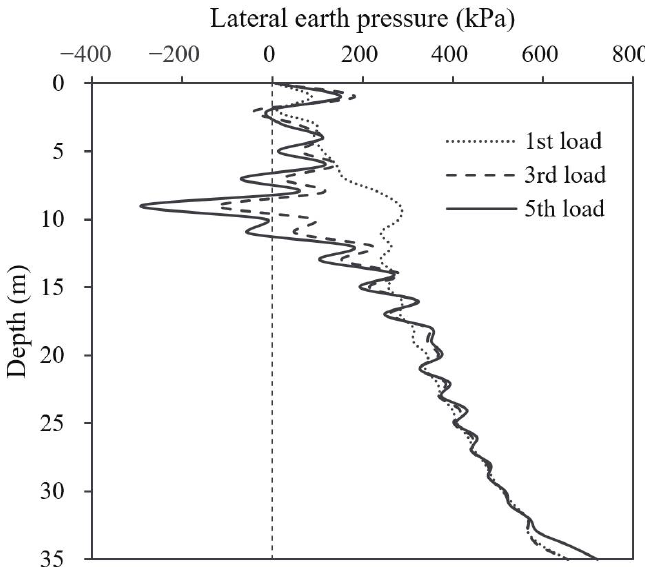
Figure 11. The distribution of the lateral earth pressure under different lift loading.